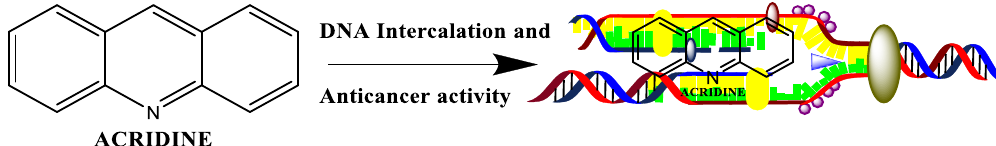
Figure 1. Acridine as an anti-tumour